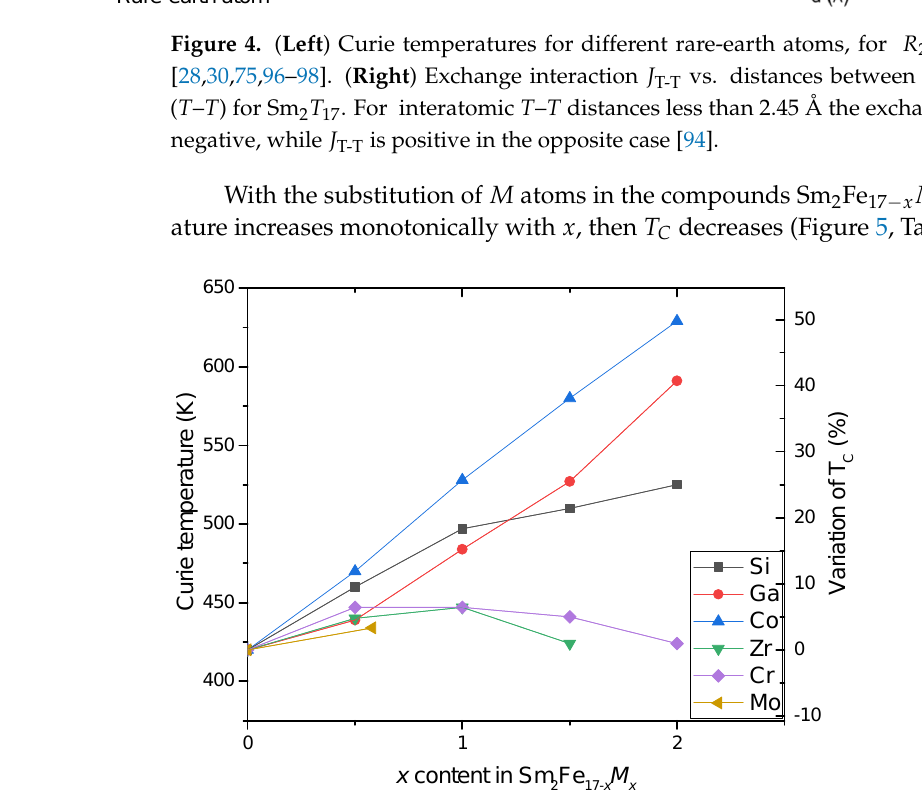
Figure 5. Curie temperature T C and variation ∆ T C / T C of Sm 2 Fe 17 − x M x for M = Si, Ga, Co, Zr, Cr, Mo